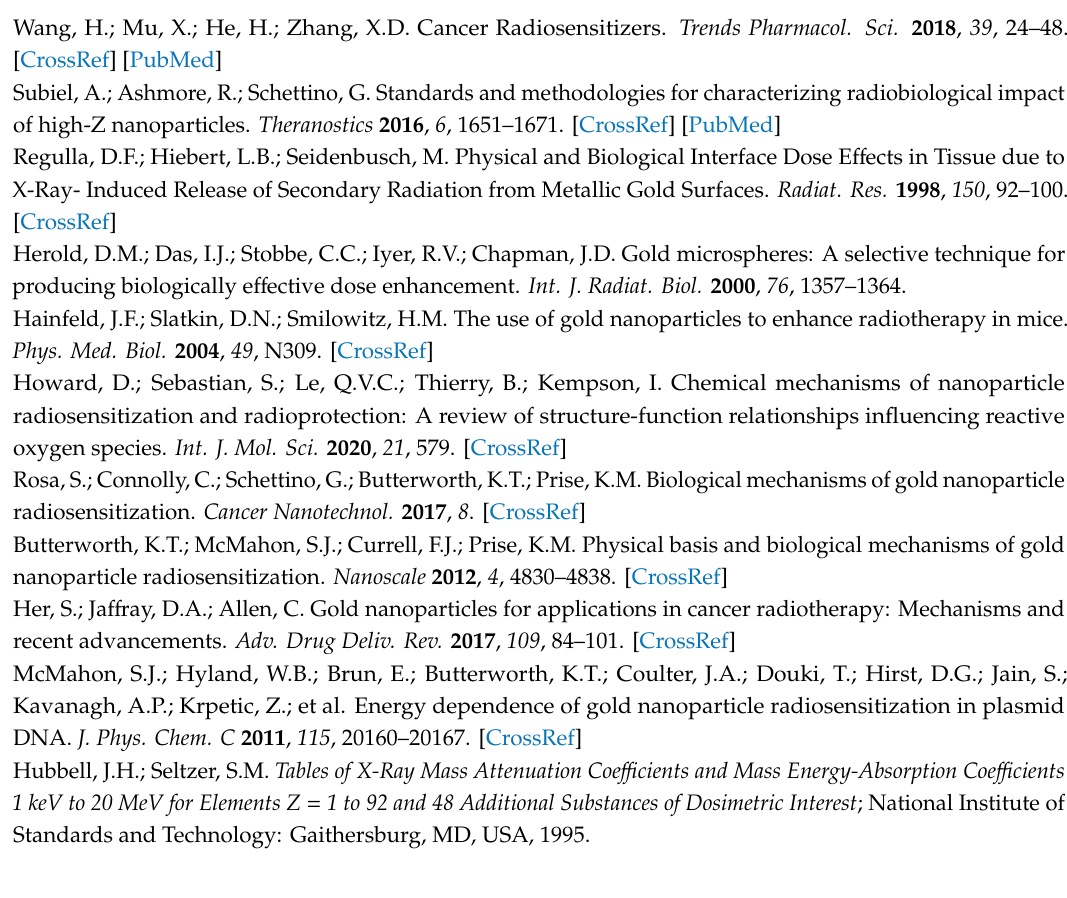
size distribution (B). Figure S3: Absorption spectra of AgNPs prepared by borohydride reduction method (A) and Turkevich method (B). Figure S4: Kinetics of hydrated electrons within microsecond time range after a 5 ps electron pulse in AgNPs suspensions containing 2 mM of silver atoms (orange dots) and their supernatants (grey triangles). (A) AgNPs were prepared by the borohydride reduction method. (B) AgNPs were prepared by the Turkevich method. Figure S5: Kinetics of hydrated electrons within picosecond and nanosecond time ranges after a 5 ps electron pulse in water (black squares) and AuNPs suspension containing 2 mM of gold atoms prepared by borohydride reduction method ( λ max = 518 nm; red dots). Figure S6: Kinetics of hydrated electrons within picosecond and nanosecond time ranges after a 5 ps electron pulse in water (black squares) and AuNPs suspension containing 2 mM of gold atoms prepared by borohydride reduction method with 3 mM of sodium citrate used as a surfactant ( λ max = 517 nm; red dots). No e ff ect of additional citrate (3 mM) was observed. Figure S7: Kinetics of hydrated electrons within picosecond and nanosecond time ranges after a 5 ps electron pulse in water (black squares) and AuNPs suspension containing 2 mM of gold atoms prepared by the Turkevich method (Au:citrate ratio is 1:1.5, λ max = 533 nm; red dots). Figure S8: Kinetics of hydrated electrons within picosecond and nanosecond time ranges after a 5 ps electron pulse in water (black squares) and AuNPs suspension containing 1 mM of gold atoms prepared by the Turkevich method (Au:citrate ratio is 1:1.5, λ max = 533 nm; red dots). Figure S9: Kinetics of hydrated electrons within picosecond and nanosecond time ranges after a 5 ps electron pulse in water (black squares) and AuNPs suspension containing 2 mM of gold atoms prepared by the Turkevich method (Au:citrate ratio is 1:4, λ max = 520 nm; red dots). Figure S10: Kinetics of hydrated electrons within picosecond and nanosecond time ranges after a 5 ps electron pulse in water (black squares) and AuNPs suspension containing 1 mM of gold atoms prepared by the Turkevich method (Au:citrate ratio is 1:4, λ max = 520 nm; red